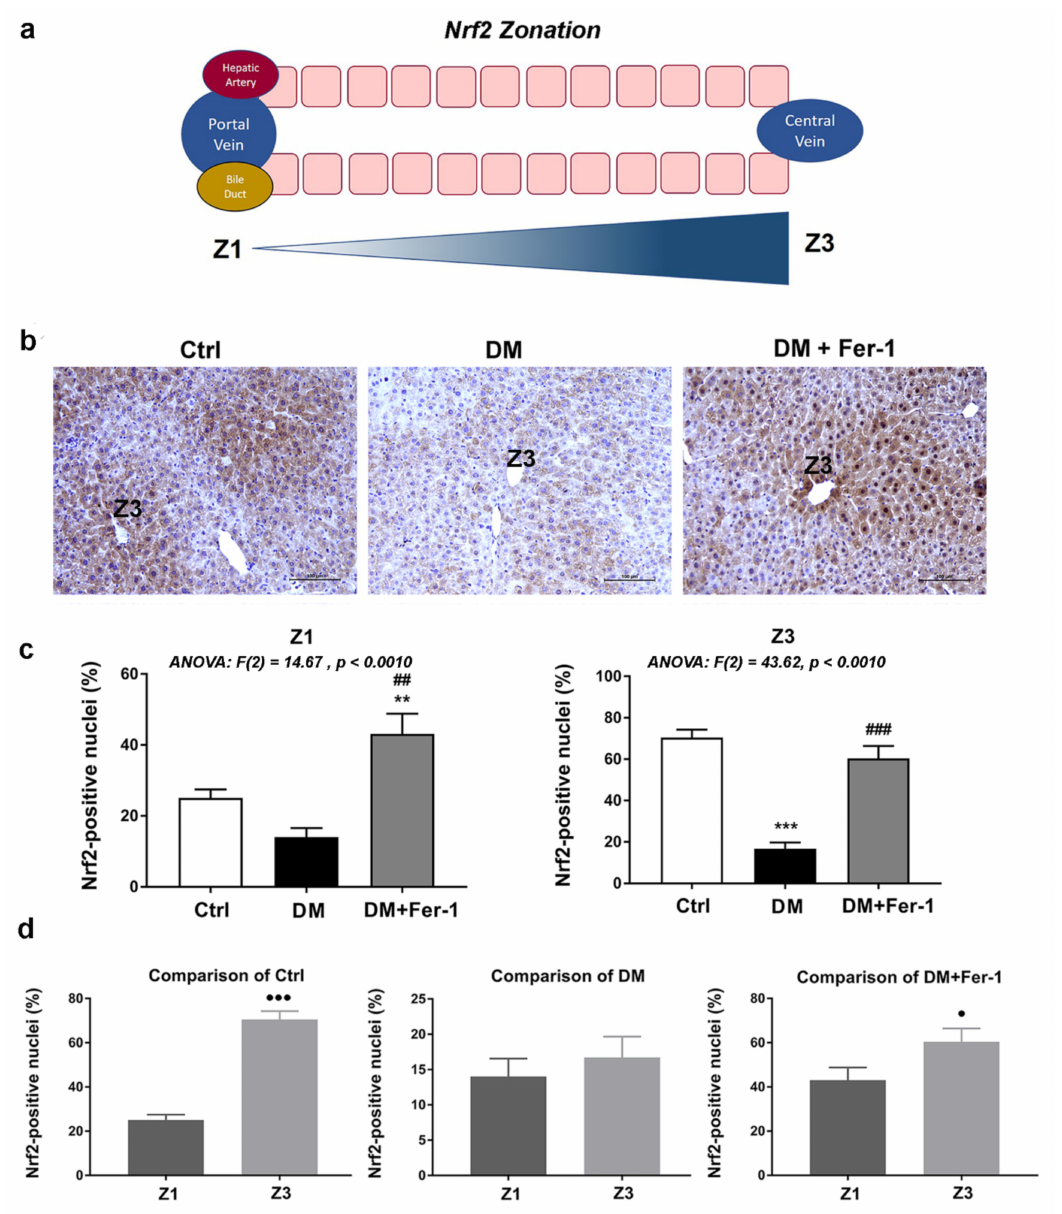
Figure 4. Immunohistochemistry of Nrf2 in liver tissue of control (Ctrl), diabetic (DM), and diabetic Fer-1-treated (DM + Fer-1) animals. ( a ) Schematic overview of structural zonation of the liver. ( b ) Immunohistochemical detection of Nrf2 expression across the liver zones; scale bars—50 µ m. ( c ) Proportion of Nrf2 positive nuclei between the groups in Z1 and Z3. ( d ) Proportion of Nrf2 positive nuclei between the zones in control, DM, and DM + Fer-1 groups. Values presented as means ± SEM. Statistical significance: compared with the Ctrl group (*), ** p < 0.01; *** p < 0.001; DM vs. DM + Fer-1 comparison (#), ## p < 0.01; ### p < 0.001. Z1 vs. Z3 comparison ( • ), • p < 0.05, ••• p <